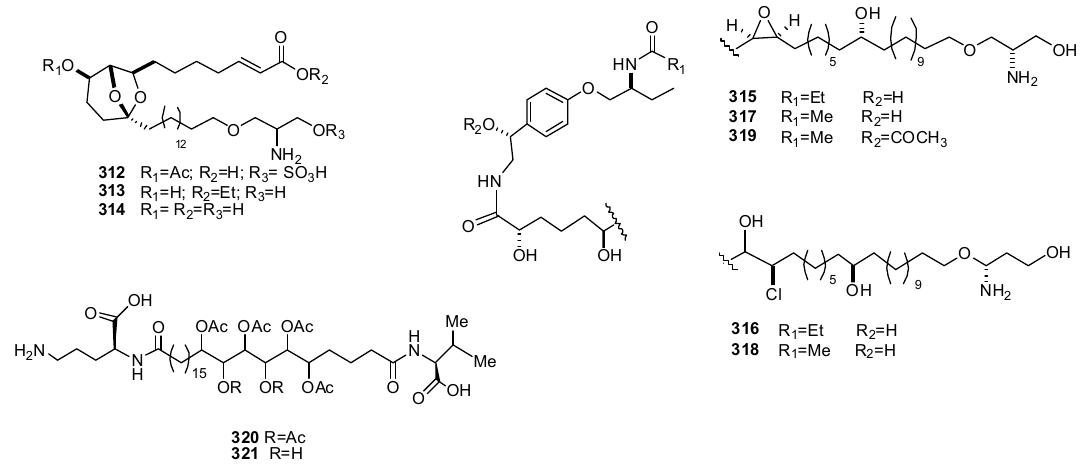
Figure 32. Structures of didemniserinolipids ( 312–314 ), shishididemniols ( 315–319 ), and sagittamides ( 320–321